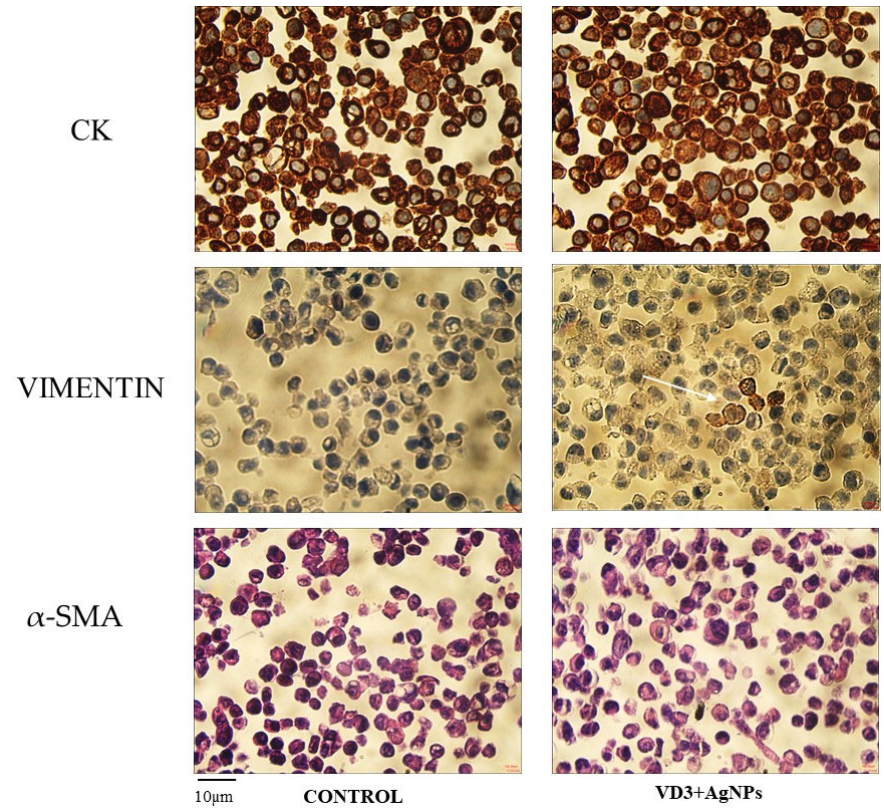
Figure 3. Immunocytochemical analysis of Cytokeratin (CK), Vimentin, and α -smooth muscle actin ( α -SMA). Cells were cultured and treated as reported in Section 4. 40 × magnification.